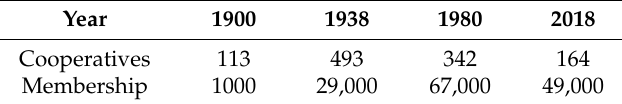
Table 1. German wine cooperatives [84,93,95].